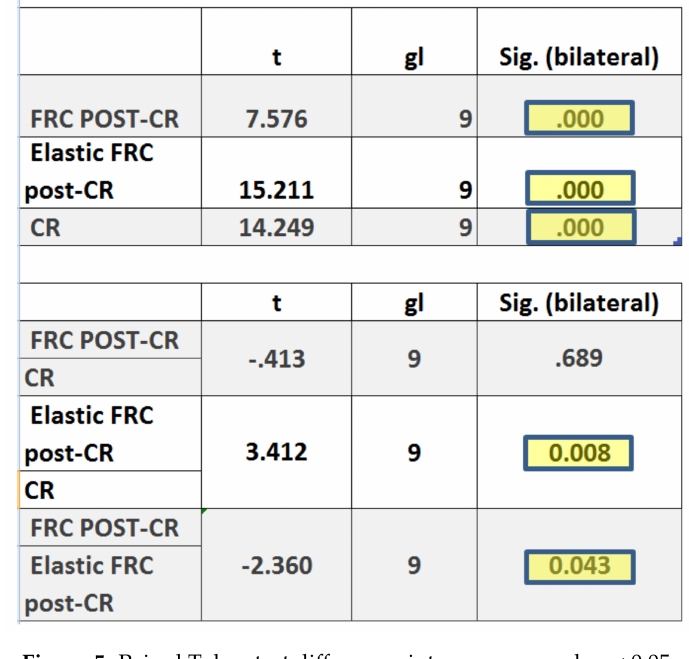
Figure 5. Paired Tukey test di ff erences inter group. p value < 0.05.